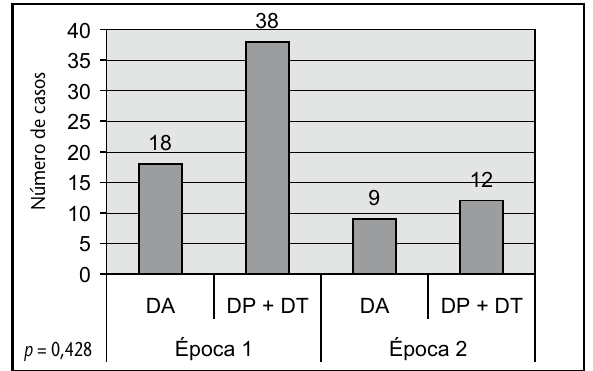
Figura 2 – Frequências de casos concordantes (DA) e discordantes (DP+DT) em 77 autópsias de adultos do HC-UFMG, realizadas em duas épocas distintas (1975 a 1978 e 1997 a 2000), com evidente diminuição numérica e relativa manutenção da proporção de casos discordantes: DA Época 1 = 18; DP + DT Época 1 = 38; DA